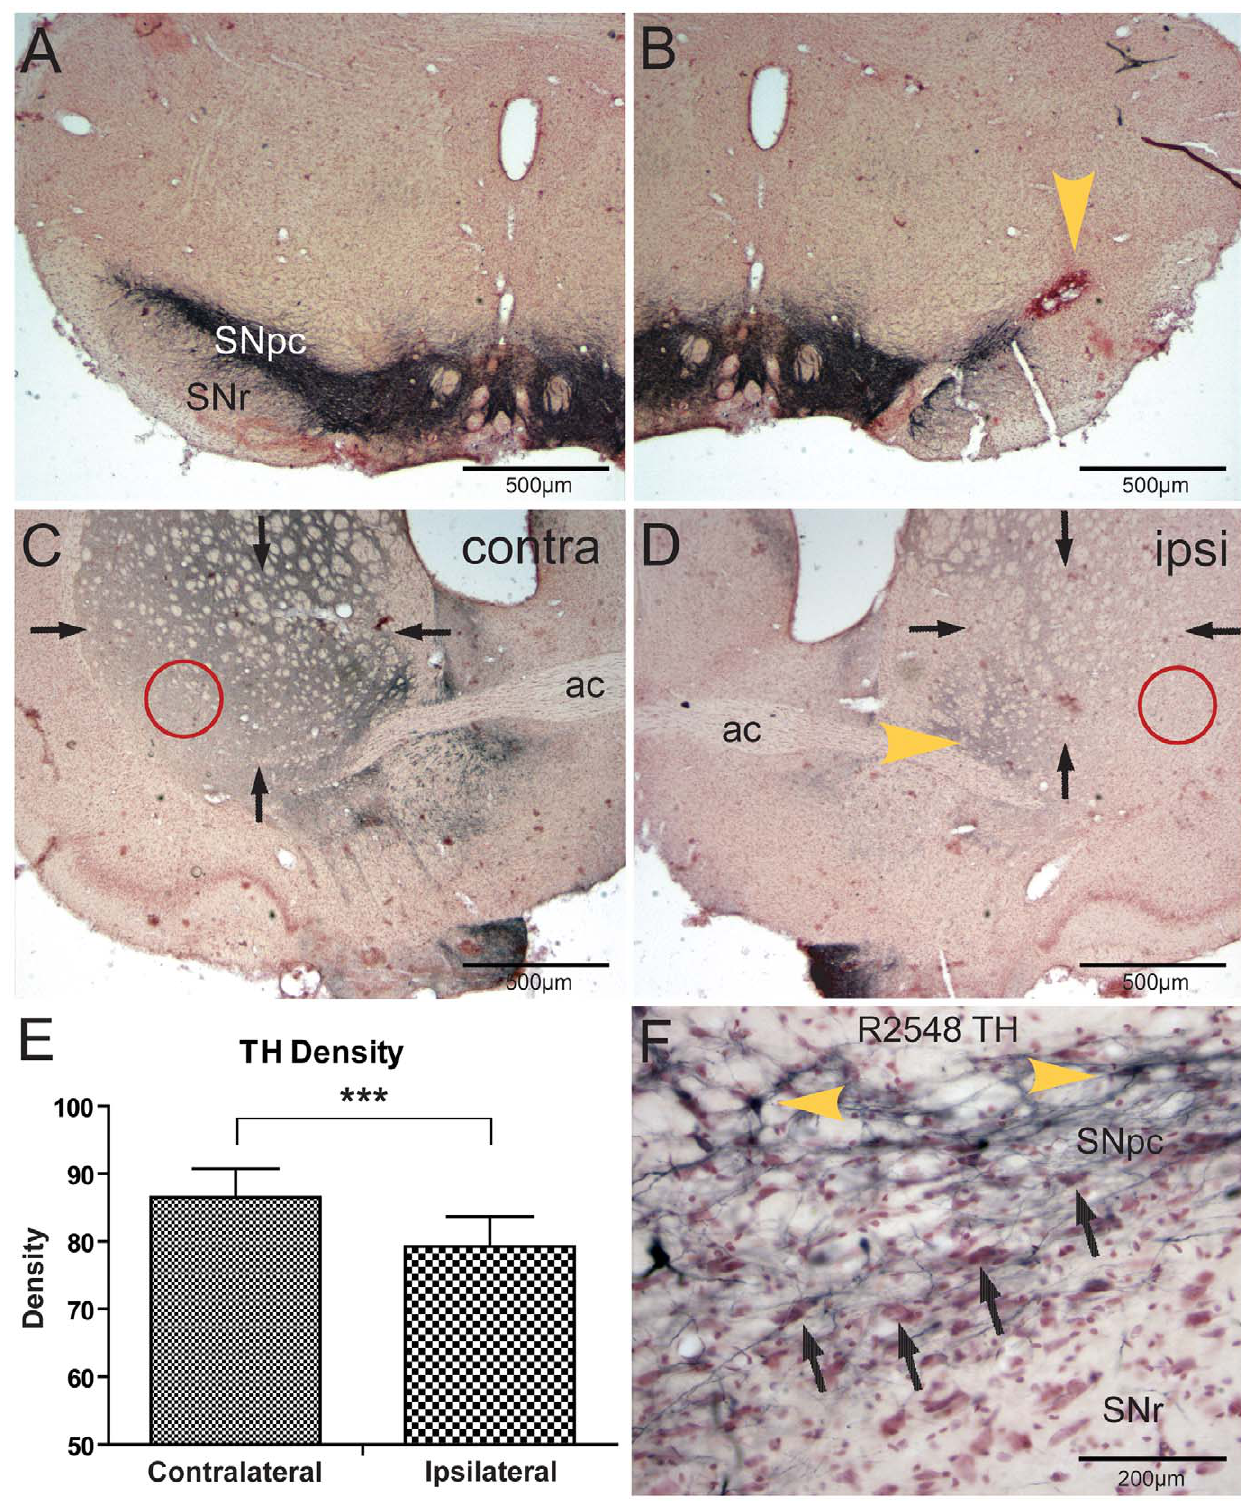
Figure 2. Photomicrographs of brain sections (case R2508) immunohistochemically-stained against tyrosine hydroxylase (TH) after injections of DOPAL into the substantia nigra, parscompacta (SNpc). Note the gross reduction of TH immunoreactivity in the SN at the site of injection ( B ; yellow arrowhead) versus the non-injected side ( A ). Similar loss of TH staining is seen in the striatum ipsilateral to the injection ( D , arrows) versus that on the non-injected side ( C , arrows), suggesting disruption of nigral dopaminergic terminals. The area just lateral to the anterior commissure ( D , yellow arrowhead) however was always densely labeled (see text). Densitometry of immunostaining of striatal TH ( E ) showed significant differences (p , 0.001) of the whole striatum contralateral and ipsilateral to DOPAL injections. Spot density measurements of ventrolateral parts of the striatum ( D , red circles), however, showed an 80% loss of immunoreactivity ipsilateral to the injection. Intensely stained neurons with